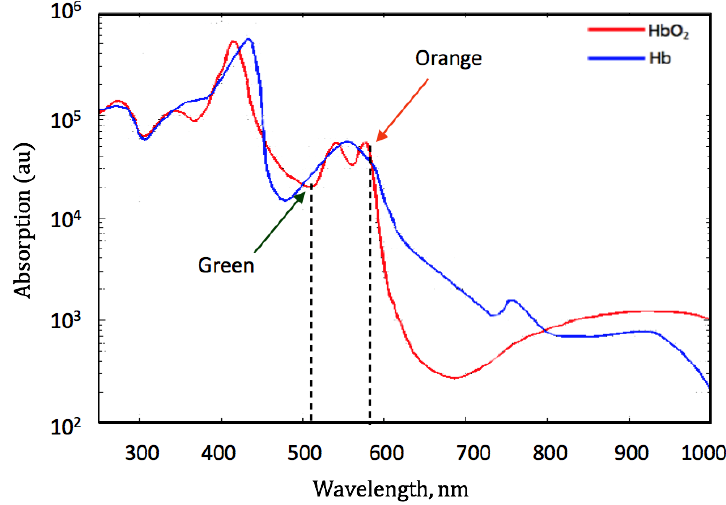
Figure 2. Absorption of Hb and HbO 2 at green and orange illuminations